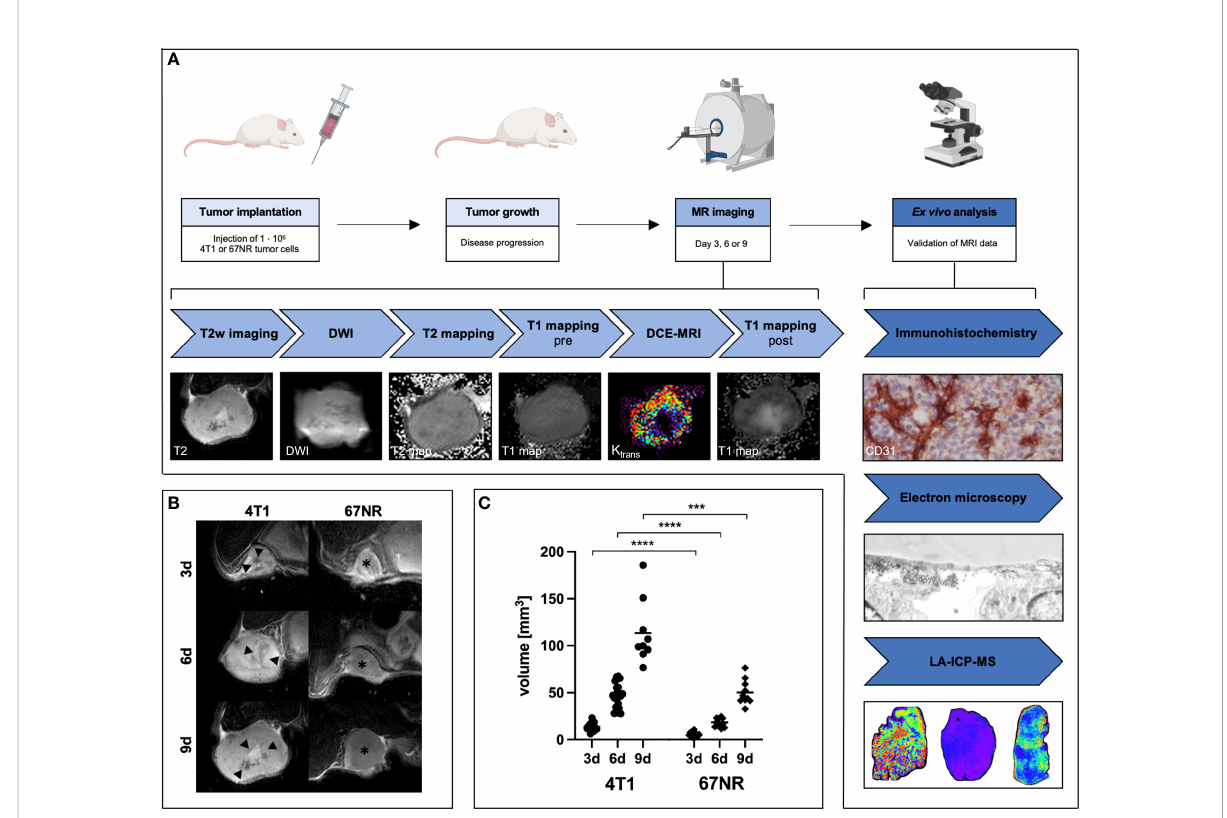
FIGURE 1 Overview over experimental setup and assessment of T2 weighted MRI images over time. BALB/c mice were implanted with 4T1 or 67NR tumor cells in the left mammary fat pad and let grow for three, six or nine days. After the multiparametric MRI scans, mice were sacri fi ced, and the tumors removed for ex vivo analyses (A) . T2 weighted images (B) of exemplary 4T1 tumors (left side) and 67NR tumors (right side), and volumetry of the tumors (C) show an increasing discrepancy between the two tumor models during progression. 4T1 tumors measured double the size of 67NR tumors on day nine. Note the already visible small necrotic/hemorrhagic areas in the 4T1 tumors (arrowheads) in comparison to the homogenous 67NR tumors (asterisks). *** p < 0.001, **** p < 0.0001. Partially created with BioRender.com (A)